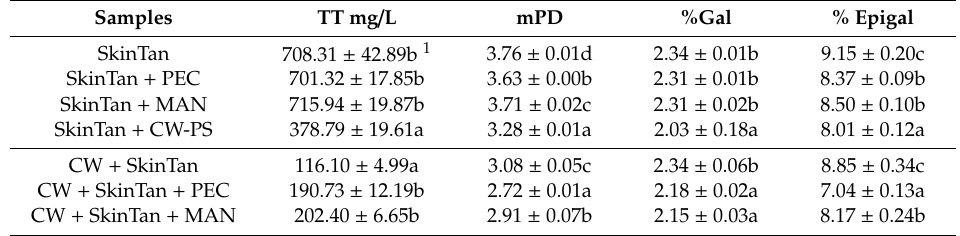
Table 1. E ff ect of the addition of soluble polysaccharides on the interaction between skin tannin and cell walls. Characterization and quantification of tannins in